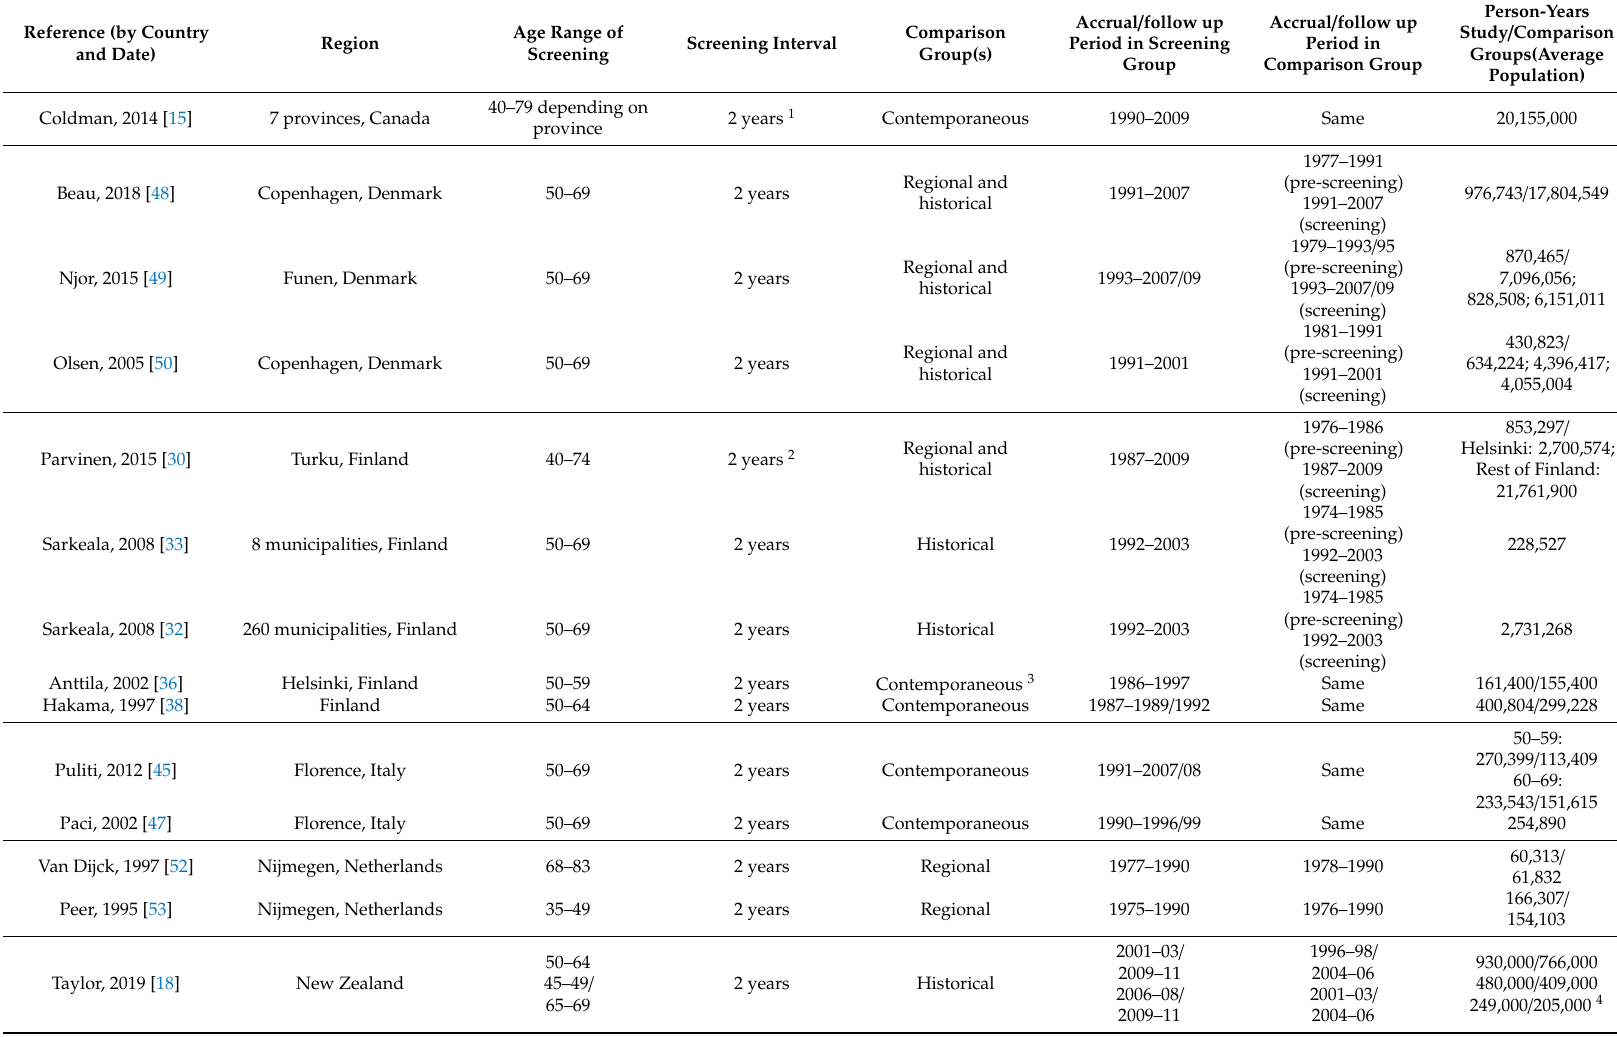
Table 2. Overview of